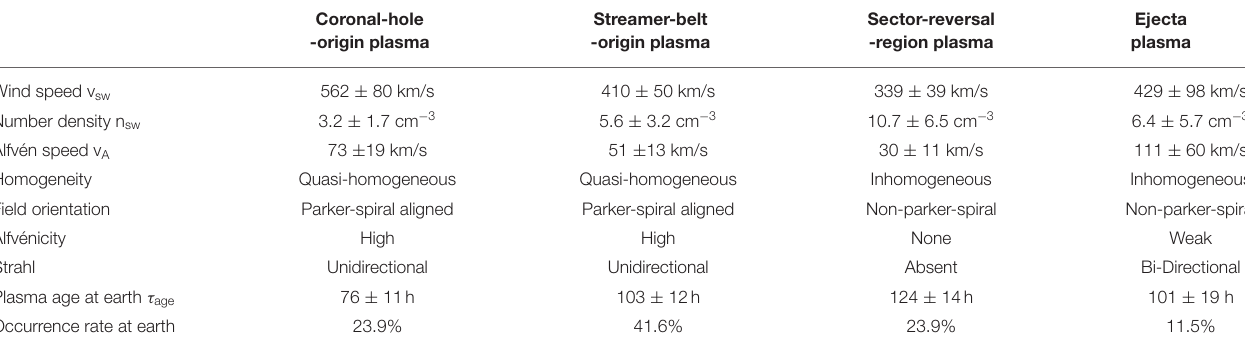
TABLE 1 | Some systematic differences in the properties of the four types of solar-wind plasma; the values are from the OMNI2 1-AU data set in the years